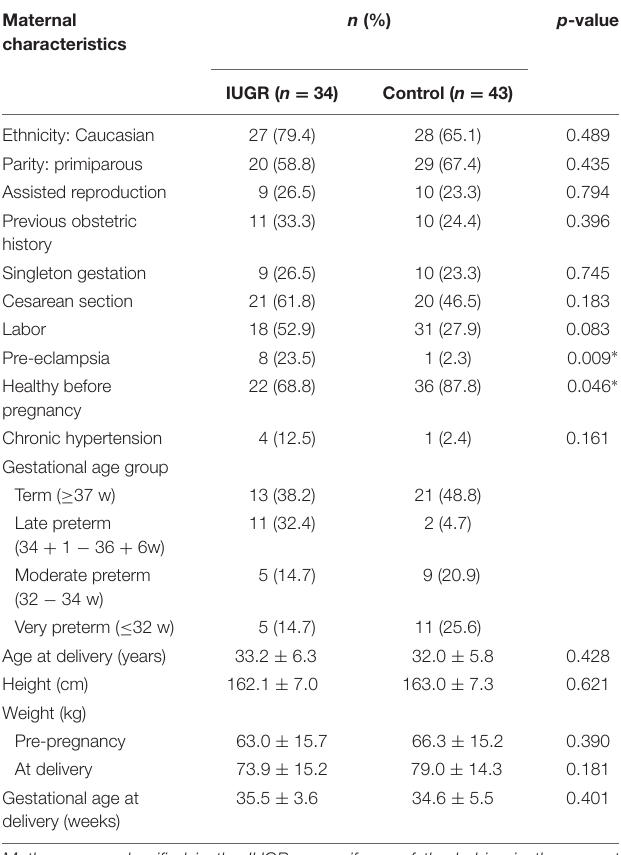
TABLE 3 | Maternal data by study